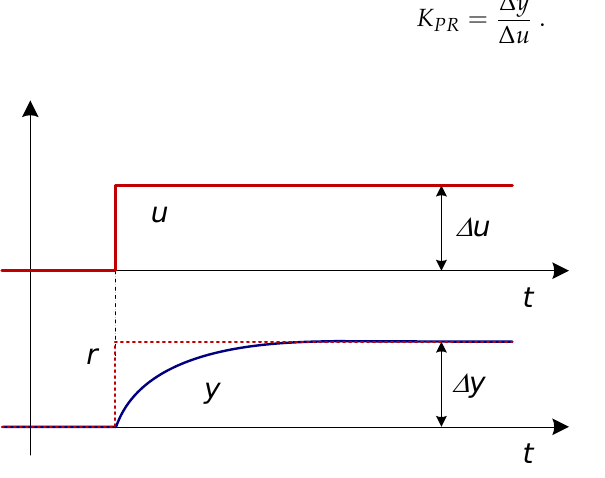
Figure 3. Typical process input ( u ) and output ( y ) signals during the open-loop or closed-loop steady-state change in the process, where r = K PR ∙ u .